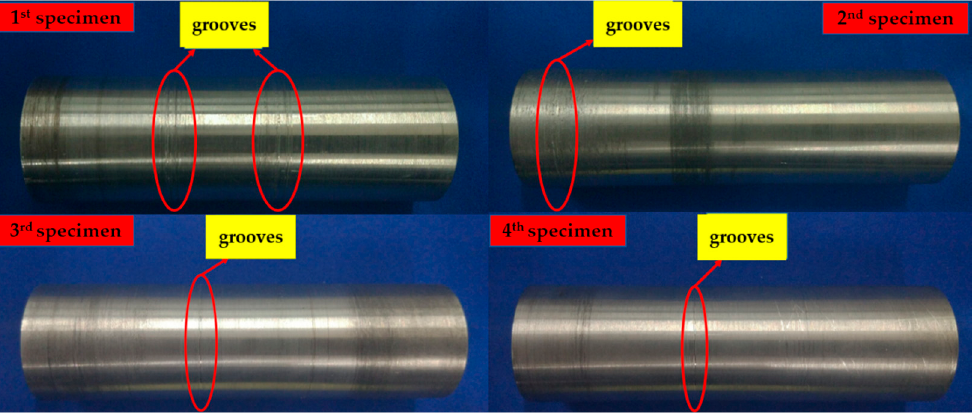
Figure 7. Worn surfaces of specimens. Table 2. Grooves on the surface of pins.